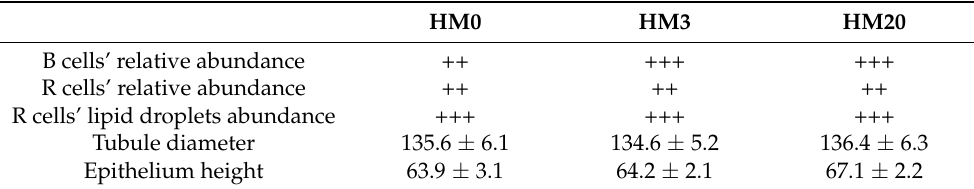
Figure 2. Histomorphology of transversal sections of hepatopancreas tubules (middle portion) of giant freshwater prawn fed post-larvae over 60 days with the test diets. ( a ) HM0, ( b ) HM3, and ( c ) HM20. Scale bars: 50 µm. Table 5. Histological indices and morphometric evaluation of tubule diameter and epithelium height measured in hepatopancreas tubules (middle portion) of giant freshwater prawn fed the experimental diets over the 60-day trial.